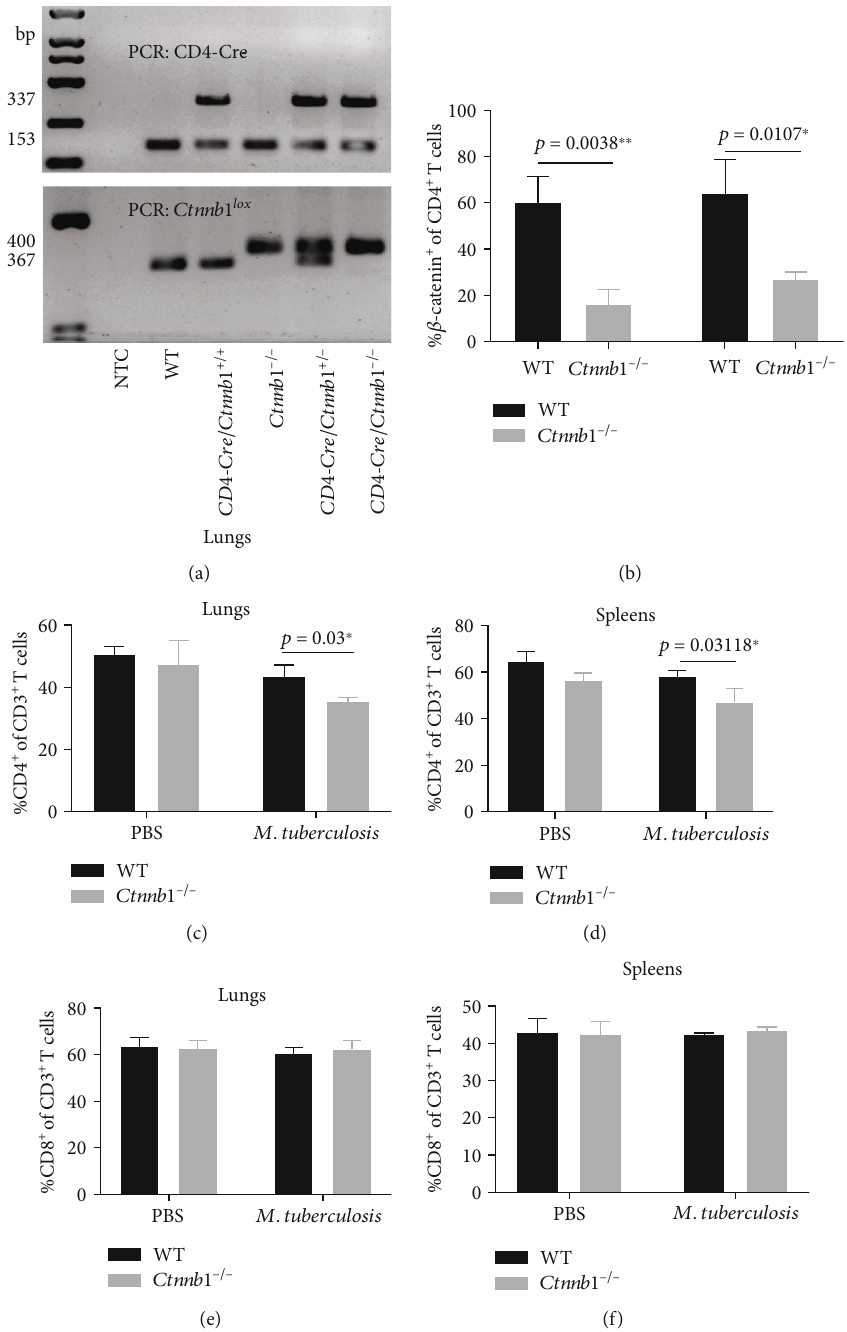
Figure 1: The genotypes of all mice identi fi ed by PCR and T cells frequency in both groups of mice by fl ow cytometry. (a) Mice ’ s genotypes were identi fi ed by PCR, and results were showed by 2.5% agarose gel electrophoresis. (b) The frequency of β -catenin + cells of CD4 + T cells in lungs and spleens of Ctnnb1 -/- mice ( n = 5 ) and wild-type mice ( n = 5 ); CD3 + CD4 + T cells were shown in the lungs (c) and spleens (d) of Ctnnb1 -/- ( n = 5 ) and wild-type mice ( n = 5 ) infected with or without M. tuberculosis ; CD3 + CD8 + T cells were shown in the lungs (e) and spleen (f) of Ctnnb1 -/- ( n = 5 ) and wild type mice ( n = 5 ) infected with or without M. tuberculosis . The experiment had three independent rounds, and results were analyzed by the Student t test. NTC, no template control. PBS, phosphate-bu ff ered mingen ™ ) (1: 100) and PE/Cy7-conjugated antihuman TNF- bu ff er. Supernatants were removed, and cells were resus- α (Clone MAb11, BioLegend) (1 : 100), incubated for 40 pended in 100 μ l of Cyto fi x/Cytoperm (BD Pharmingen ™ ), minutes at 4 ° C, then washed with 500 μ l perm/wash bu ff er. then incubated for 40 minutes at 4 ° C. After washing, cells were suspended in diluted intracellular antibodies PerCP- After cell staining, cells were resuspended in 100 μ l of 1% Cy ™ 5.5-conjugated antihuman IFN- γ (Clone B27, BD Phar- paraformaldehyde.